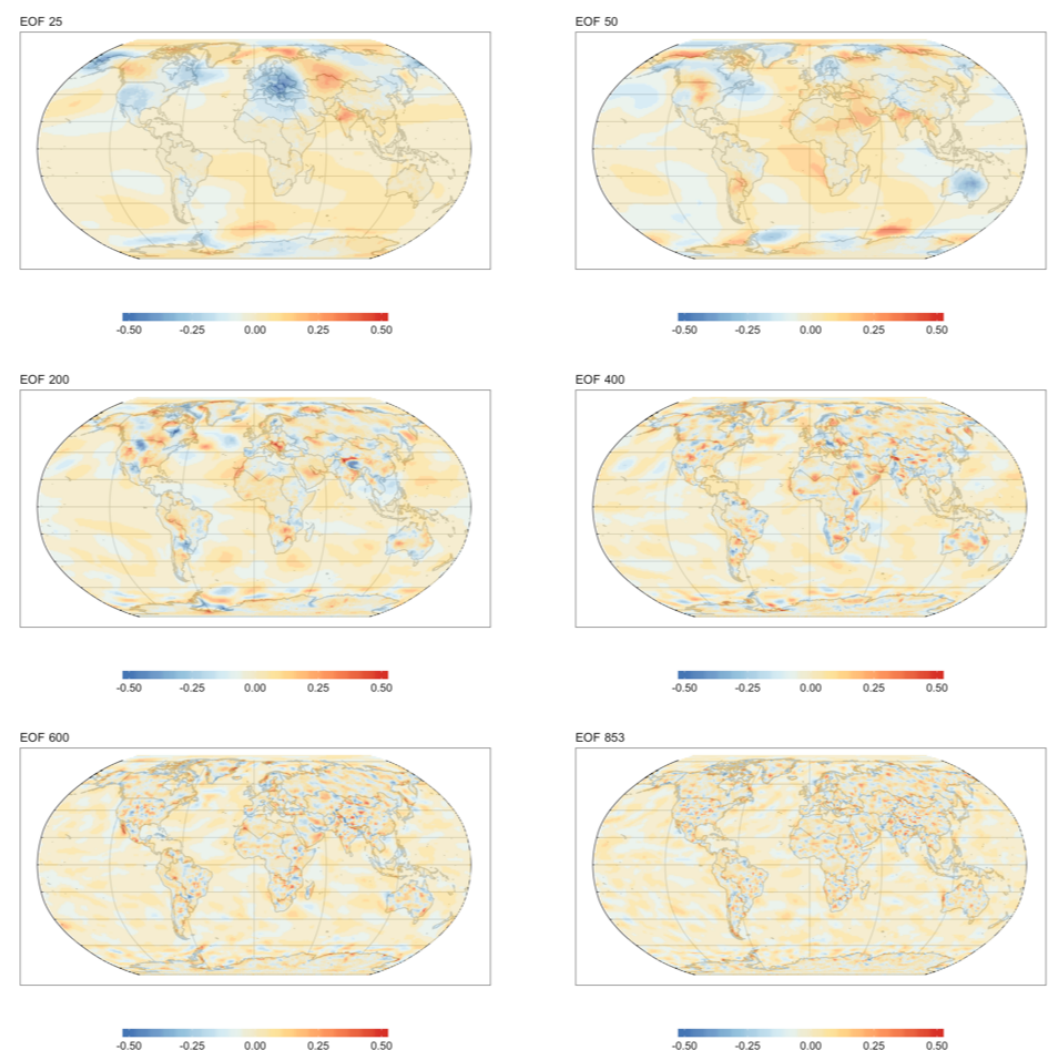
Figure 7. Spatial visualizations of higher EOF basis functions. EOF grid cell values are scaled such that the magnitude of the largest value is 1. The characteristic scale of temperature fluctuations decreases for functions later in the series. Thus, EOFs 25 and 50 show features at about half the scale of those shown in Fig. 6, while features in EOFs 200 and 400 are roughly one-quarter the scale. By the time we get to the last few hundred EOFs, features are just a few grid cells in size resulting in patterns that might be thought of as spatially structured